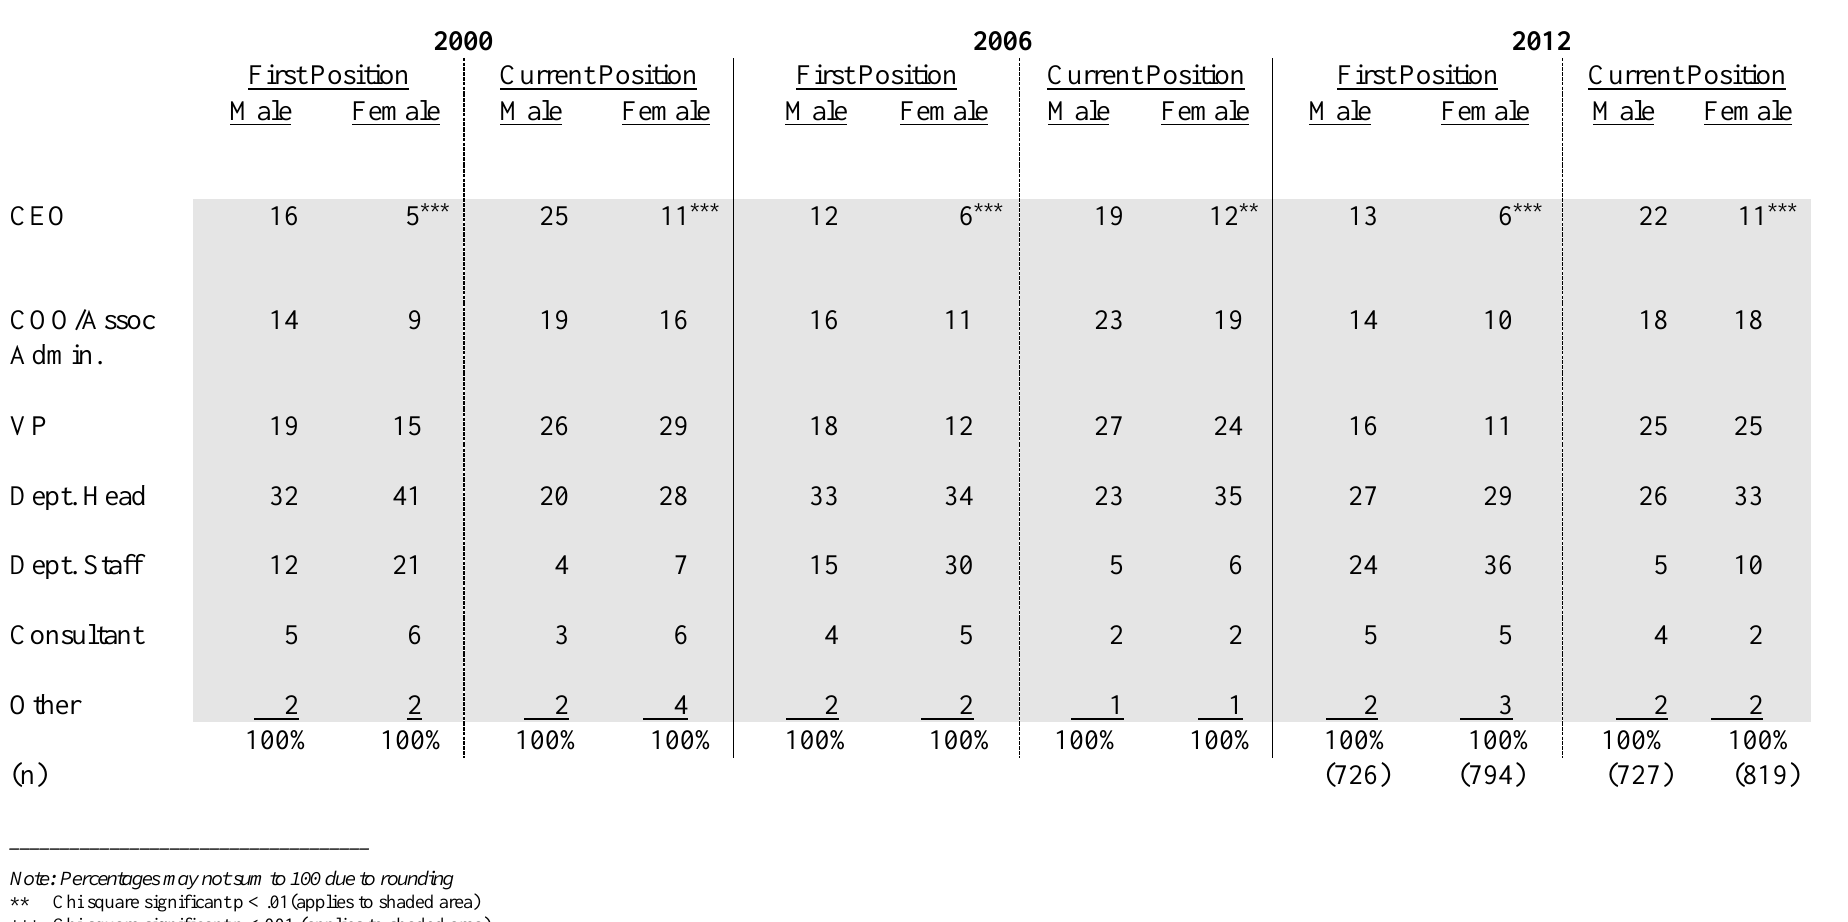
Table 15. First and Current Position Within Current Firm